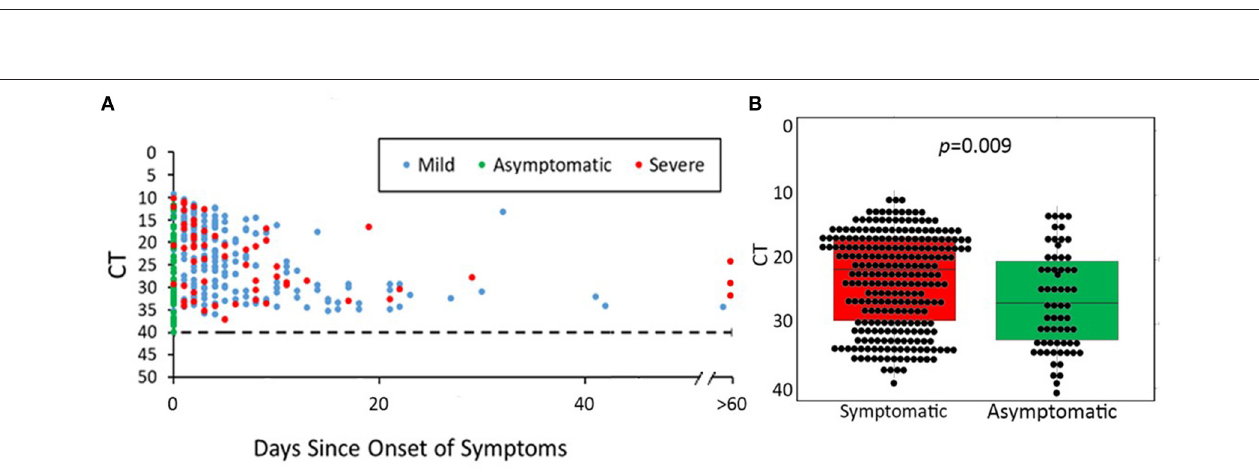
FIGURE 3 | Number of reported symptoms at time of SARS-CoV-2 testing by age and test result. Linear regression and correlation coefficients estimate the change in number of symptoms by age. Youth with positive SARS-CoV-2 results had a significant correlation between age and number of symptoms ( r = 0.30, p < 0.001); youth with negative results had no significant correlation between age and number of symptoms ( r = 0.06, p = 0.25). Presence of symptoms increased significantly with age ( p < 0.001). Youth with positive SARS-CoV-2 results are plotted in blue and youth with negative SARS-CoV-2 results are in red.